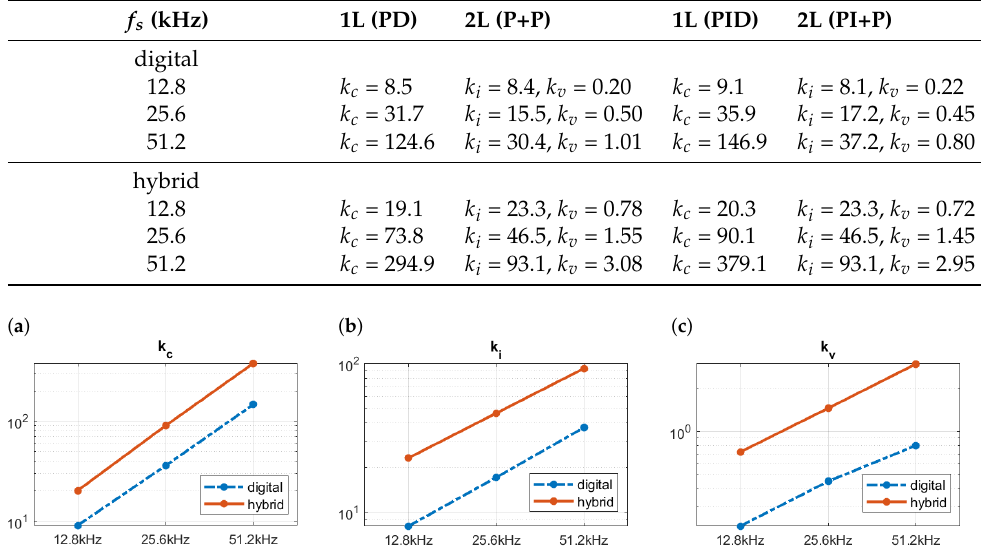
Figure 13. Dependence of ( a ) the gain k c for PID single-loop controllers, ( b ) k i and ( c ) k v of PI+P double-loop structures as functions of carrier frequency f s in both digital and hybrid implementation. The difference between the THD values obtained using various values of k c as func- tions of the gain margin ∆ A at different carrier frequencies f s are displayed in Figure 14. These characteristics can be used to determine the effect of controller detuning.